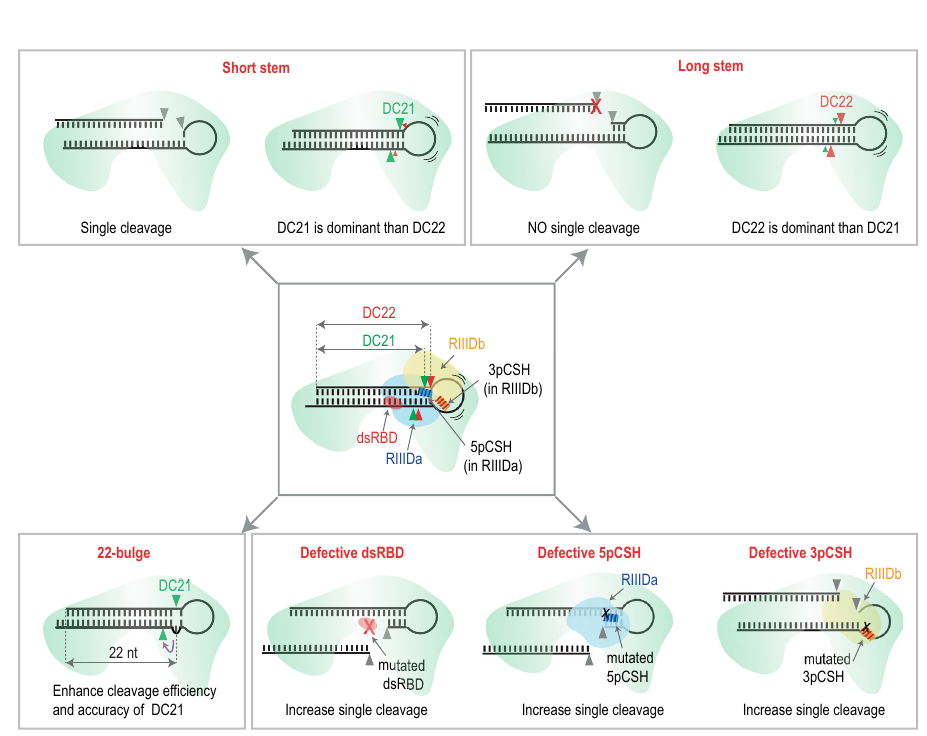
Fig. 6 The single cleavage of DICER. a The relative single cleavage (SC) of DICER was calculated as the ratio of SC to DC. The number of variants for each stem length: n = 1550 (19 nt); n = 2497 (20 nt); n = 2947 (21 nt); n = 6327 (22 nt); n = 3349 (23 nt); n = 1675 (24 nt); n = 953 (25 nt); n = 597 (26 nt); n = 132 (27 nt). The error bars were presented with 95% con fi dence intervals. b Human pre-miRNAs and their variants. The mutated nt are shown in red. The stem length of pre-miRNAs was the number of base pairs and mismatches from their 5'-end to their apical loop. c , d The in vitro DICER cleavage assays for human pre-miRNAs and their variants. The assays were repeated three times. e , f The two RNase III domains of human DICER (PDB: 5ZAM) 10 were fi tted with the RNA duplex. The RIIIDs of DICER from PDB: 5ZAM 10 were superimposed on the RIIIDs of DROSHA from PDB: 6V5B 39 or PDB: 6LXD 40 . The RNA duplex was a part of a pri-miRNA in PDB: 6V5B 39 . The RIIIDa of DICER is in light pink, and the 3pCSH is in violet. The dashed line indicates the anticipated loop of the pre-miRNA. g The fractions of the shRNA variants sharing the same stem length and exhibiting 3p-strand or 5p-strand SC. h Superimposition of the RIIIDb of DROSHA and the RIIIDa or RIIIDb of DICER. DROSHA_RIIIDb is in cyan (PDB: 6V5B) 39 , DICER_RIIIDa is in violet (PDB: 5ZAM) 10 , and DICER_RIIIDb is in blue (PDB: 5ZAM) 10 . The root-mean-square deviation (rmsd) and the number of aligned residues are shown. The superimposition and fi gures were drawn using PyMOL (http://www.pymol.org). i Close-up view of the possible interaction between 3pCSH and RNA. j , l The in vitro DICER cleavage assays. k , m Bar graphs showing ratios of the SC to the double-cut product (F1) band density (SC/DC ratios) from three repeated experiments as shown in ( j, l ). In ( k , m ), a two-tailed t-test calculated the p-values. The error bars were presented with 95% con fi dence intervals. Source data are provided as a Source Data fi le.